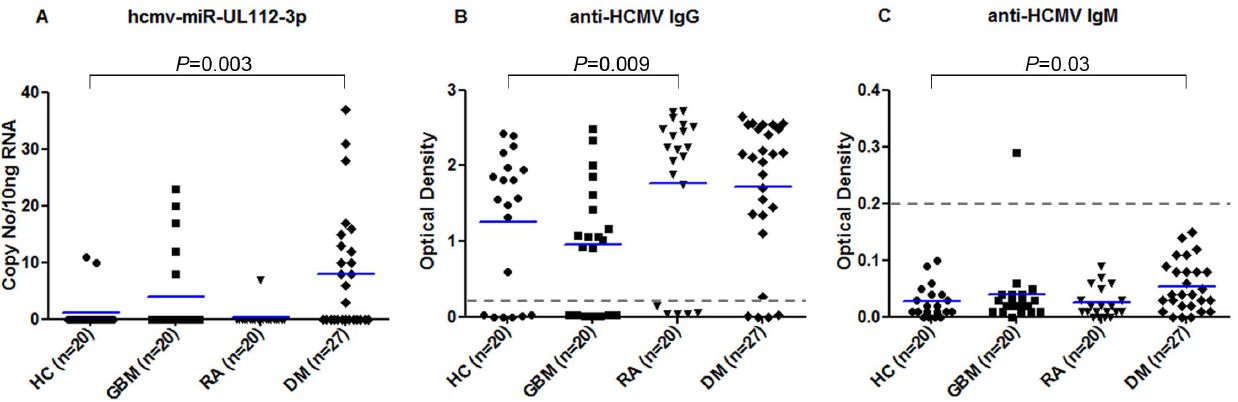
Figure 3. hcmv-miR-UL112-3p TaqMan assay and ELISA: The copy number of hcmv-miR-UL112-3p was extrapolated from the standard curve and normalised to 10 ng of total RNA (A). ELISA for the anti-HCMV IgG (B) and IgM (C) optical density values (OD); the cut-off value for the positivity was OD . 0.2 (dotted line in figure 3B and 3C). HC 5 Healthy Controls, GBM 5 Glioblastoma multiforme, RA 5 Rheumatoid Arthritis and DM 5 Diabetes Mellitus (patients from the DIGAMI-2 cohort).